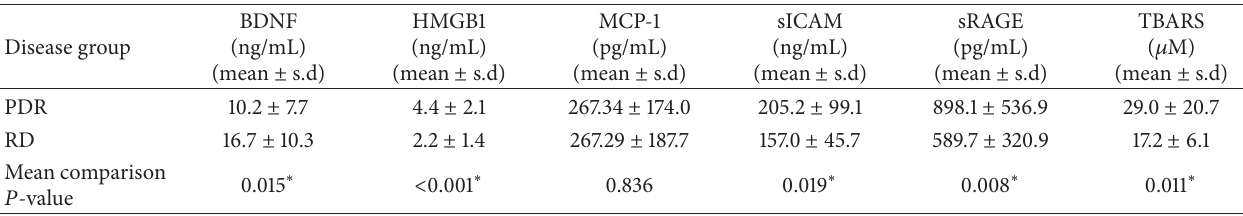
Table 1: Comparisons of mean levels for brain-derived neurotrophic factor (BDNF), high-mobility group box-1 (HMGB1), monocyte chemoattractant protein-1 (MCP-1), soluble intercellular adhesion molecule-1 (sICAM-1), soluble receptor for advanced glycation end products (sRAGE), and thiobarbituric acid reactive substance (TBARS) in serum